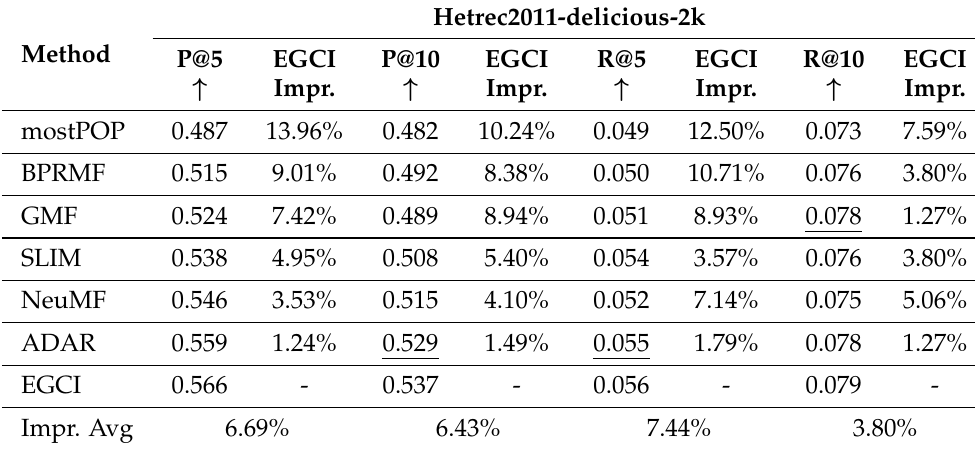
Table 5. Comparison of precision and recall on the Hetrec2011-delicious-2k dataset.